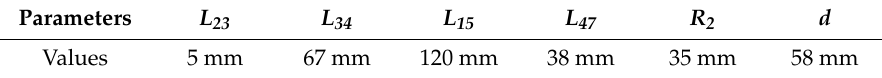
Table 2. Structure parameters of the measurement